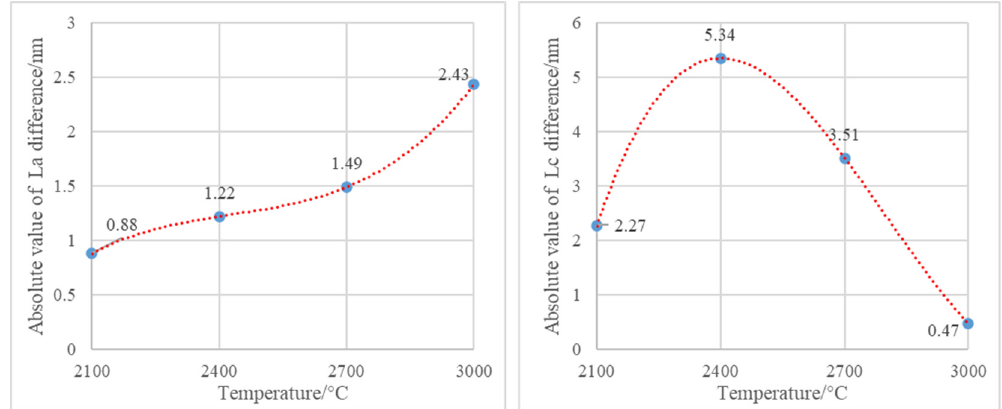
Figure 12. Difference in La/Lc of G and GS sample evolution characteristics with temperature.